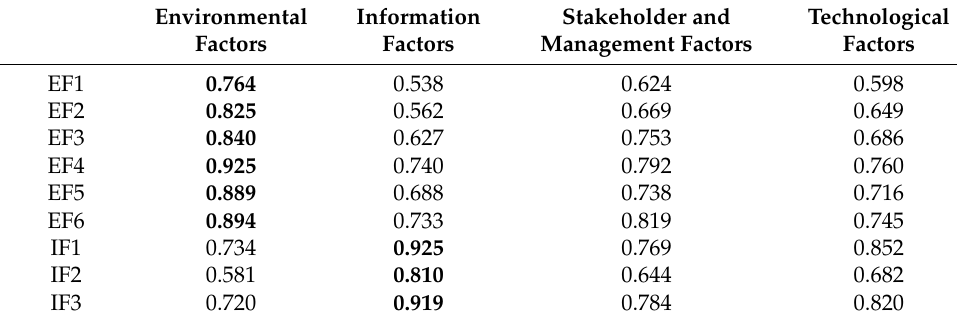
Table 7. Cross loading of measurement